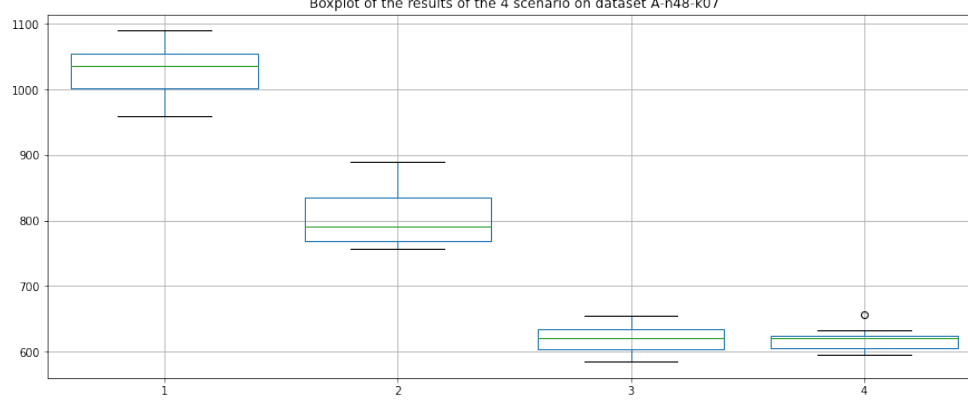
Figure 10. Boxplot of scenarios on the A-n45-k7 task of ABEFMP.